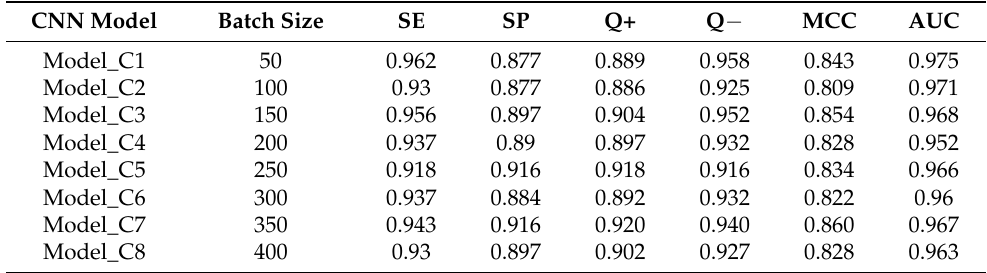
Table 2. Test results of the CNN classification models under different batch